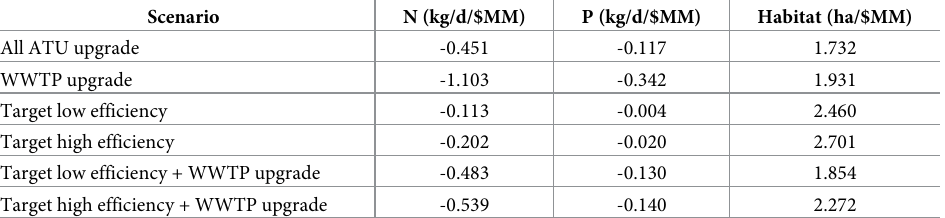
Table 5. Return on investment for each management strategy in terms of N, P, and habitat quality (change in physical units per million dollars